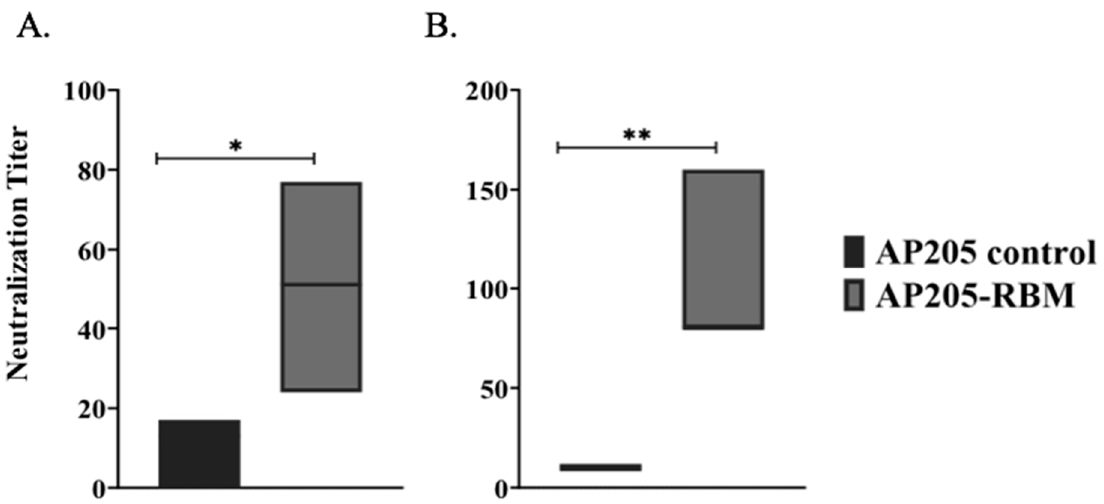
Figure 5. The AP205-RBM vaccine candidate induces antibodies neutralizing SARS-CoV2. ( A ) Neutralization titer of the induced antibodies using a SARS-CoV-2 pseudotyped vesicular stomatitis virus (VSV) assay. ( B ) Neutralization titer of the induced antibodies using CPE method and 100 TCID50 of SARS-CoV-2/ABS/NL20 virus. One representative of 2 similar experiments is shown. The value of p < 0.05 was considered statistically significant (* p < 0.01, ** p < 0.001).